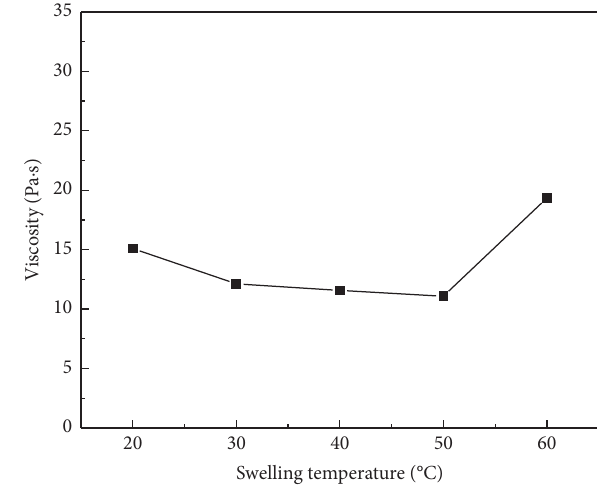
Figure 3: Influence of line SBS concentrations on the viscosity of SBS solutions.